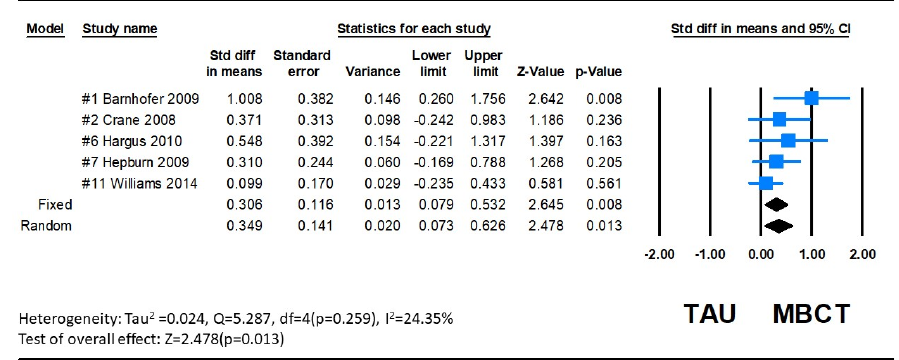
Figure 6. Forest plot of BDI ‐ II effect of MBCT on depression.